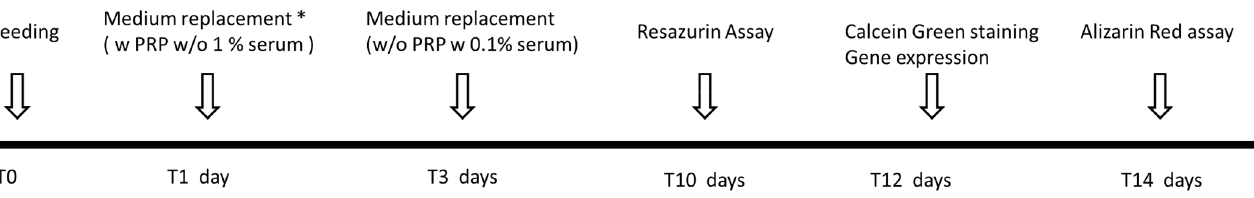
Figure A2. Timetable of in vitro experiments. * Details on culture media composition are reported in Materials and Methods section.